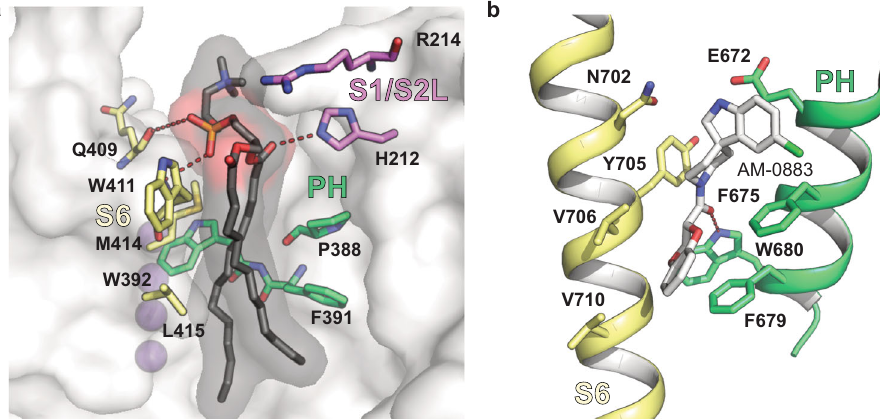
Fig. 9 Lipid binding site near the turret domain of Kv3.1a resembles known drug binding sites in other channels. a Kv3.1a residues in the pore domain (S6 in yellow, PH in green) involved in hydrophobic interactions with the fatty acid tails (black) of the lipid bound to the groove at the PD/VSD interface. Residues from the nearby S1/S2 linker are coloured in pink. K + ions are represented as purple spheres. b Binding site for agonist AM-0883 (white) between S6 (yellow) and PH (green) of TRPC6